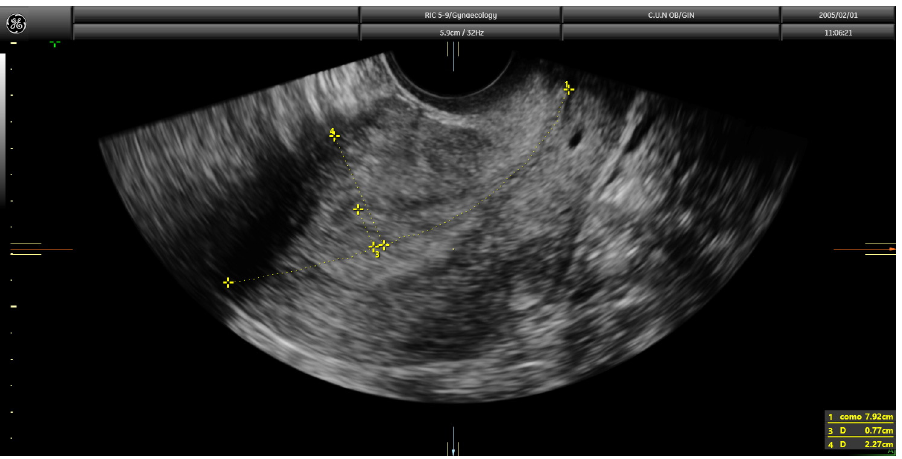
Figure 1. Transvaginal ultrasound showing a case of superficial infiltration in endometrial cancer using the Gordon’s method. The ratio of endometrial thickness/uterine anteroposterior diameter was